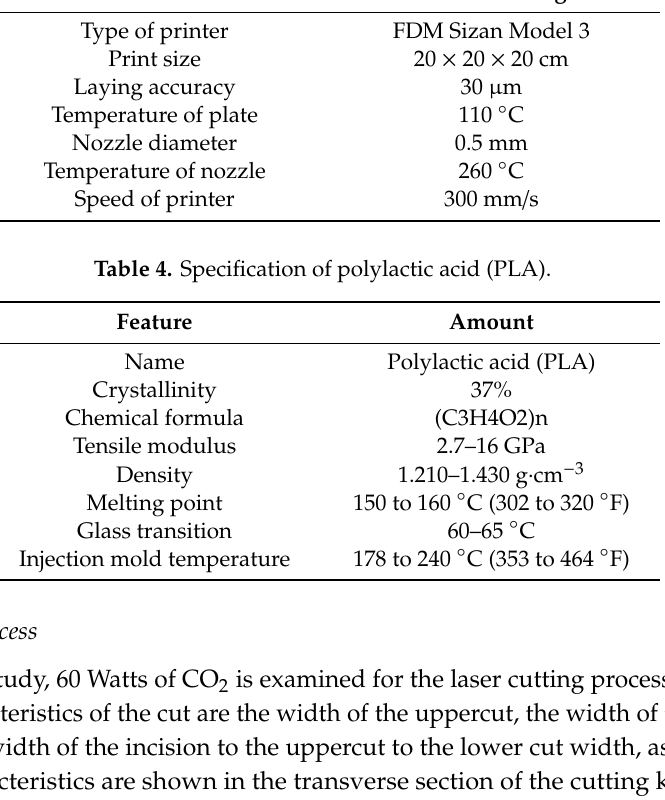
Table 3. Printer specifications.